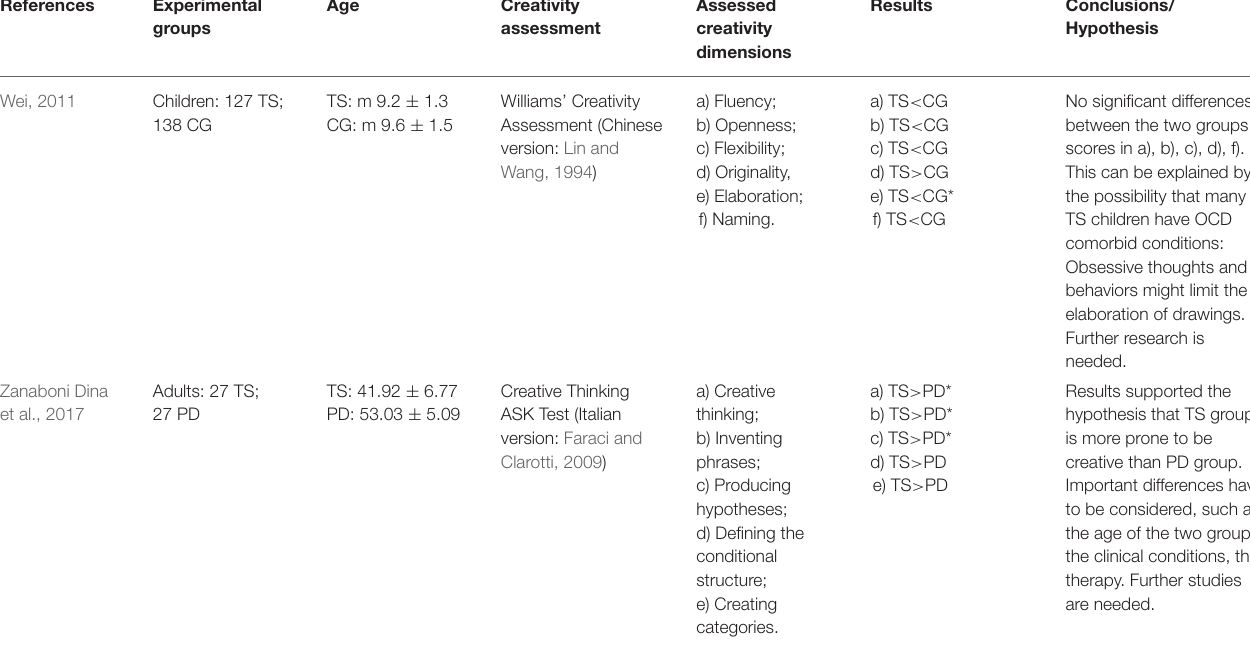
TABLE 1 | Included